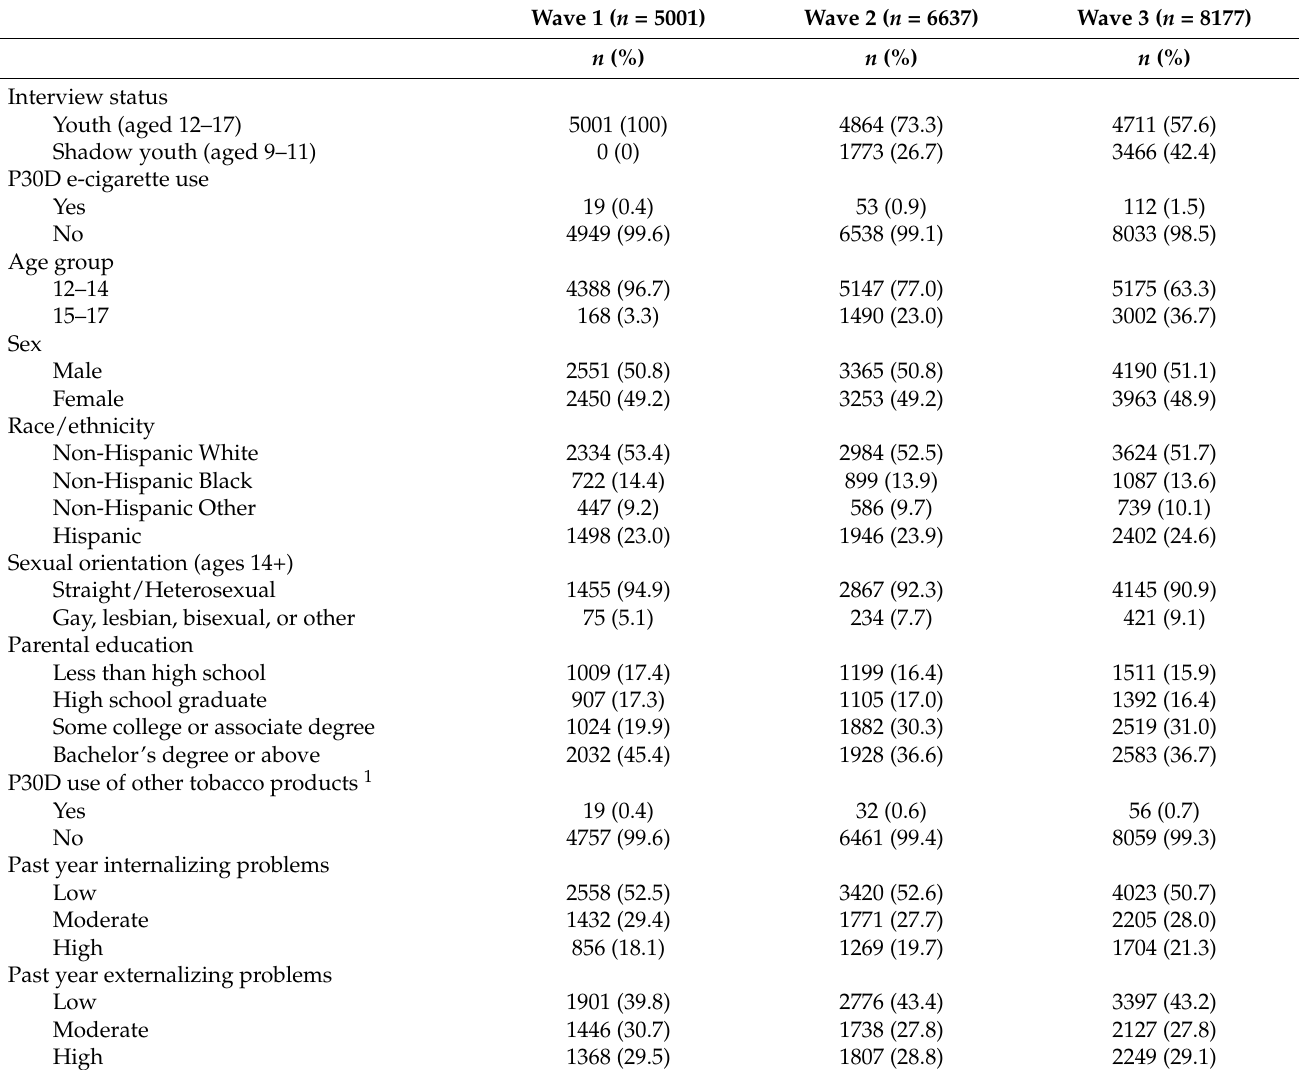
Table 1. Descriptive statistics of covariates at baseline waves among adolescents (12–17 years of age) who reported never having smoked